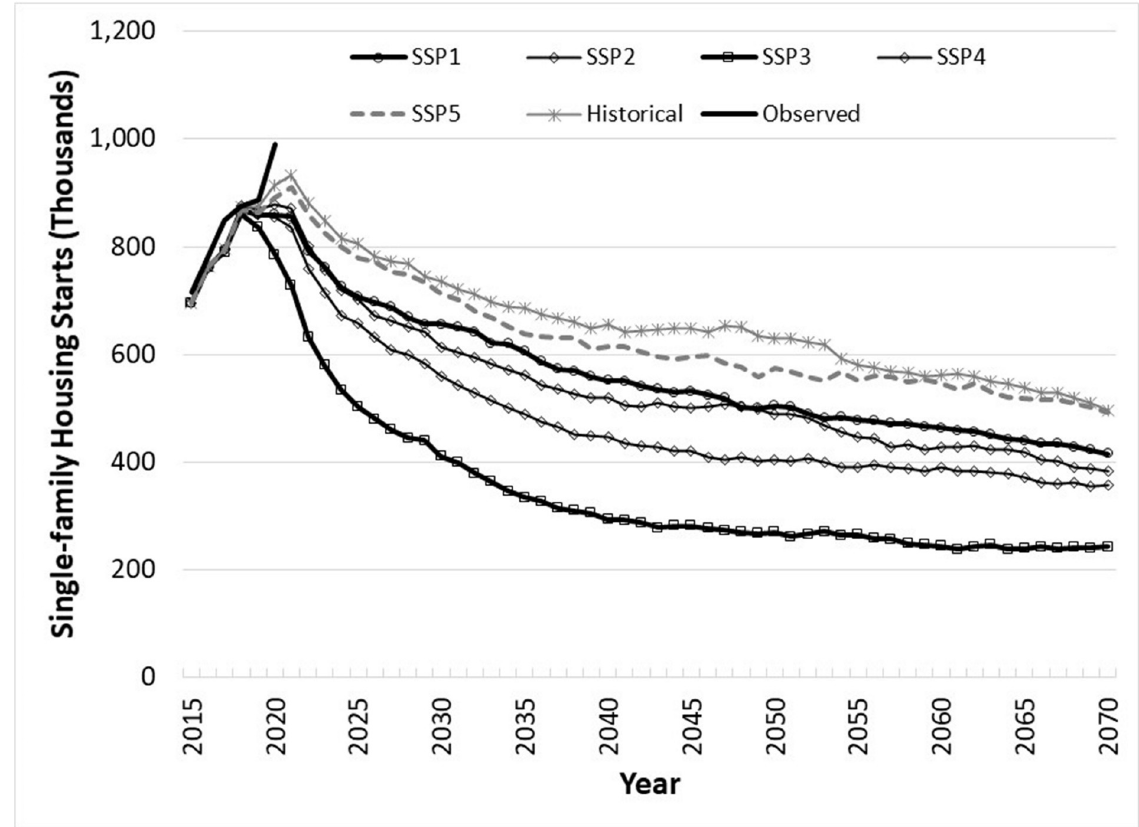
Fig 1. Annual U.S. single-family housing starts projections, 2015–2070, by Shared Socioeconomic Pathway and historical GDP and population growth rates, based on log-linear regional starts models, summed across median regional levels, based on 1,000 Monte Carlo